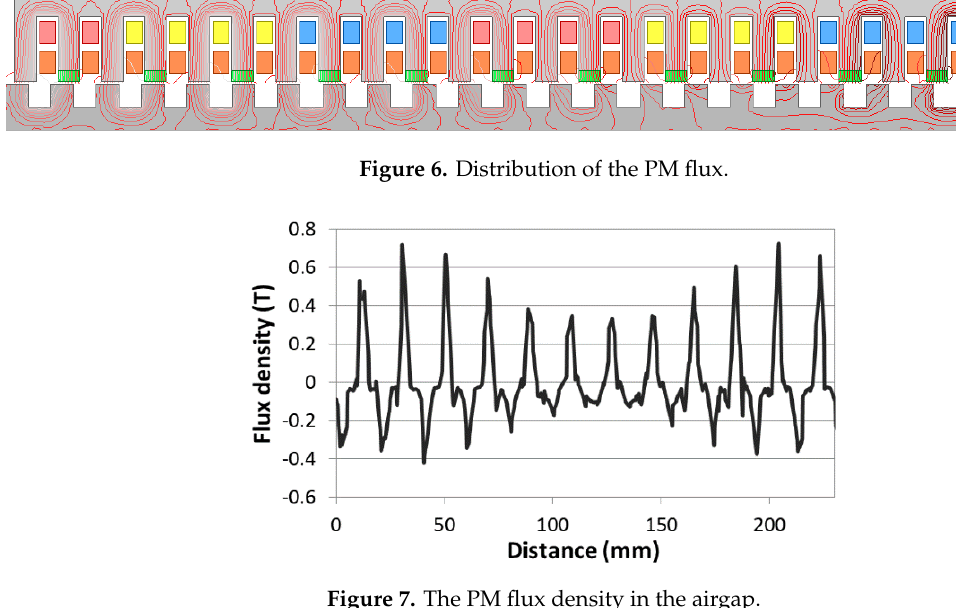
Figure 7. The PM flux density in the airgap.